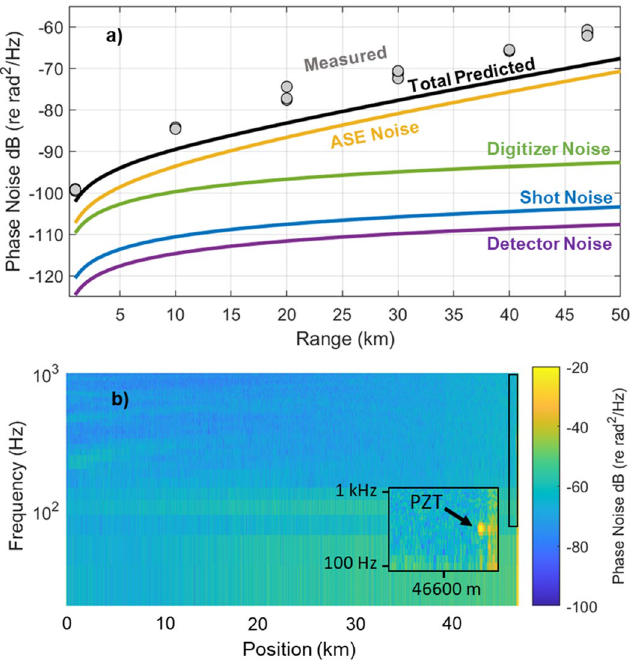
Figure 7. Range dependence of the sensor. ( a ) The predicted phase noise is shown as a function of the FUT length and compared to the experimentally measured noise. The measured noise follows the predicted trend, but diverges slightly at long range. ( b ) A typical spectrogram recorded using 20 pulses and a 47 km FUT. Inset: The PZT modulation is clearly visible at end of the